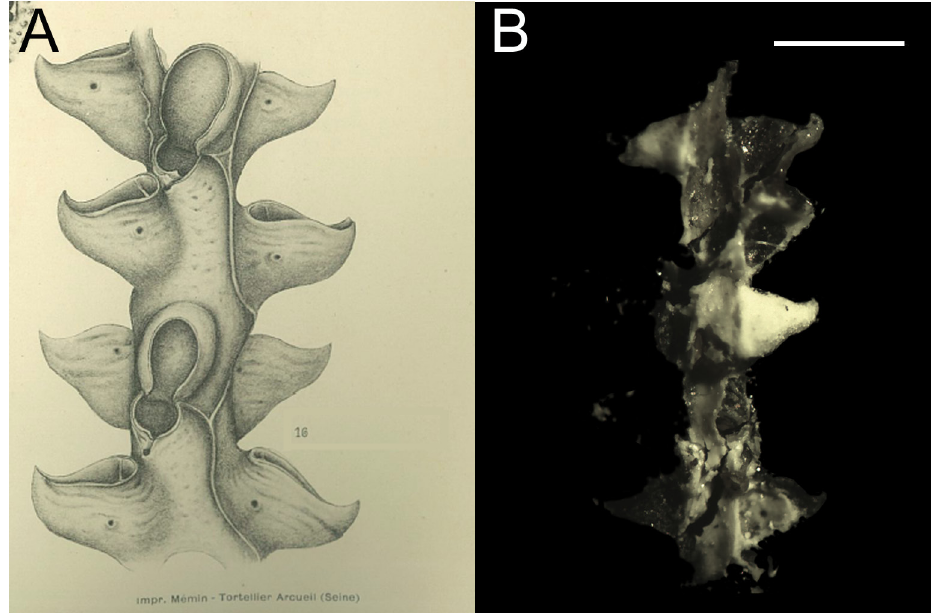
Fig. 6. Available characteristics of Schizoretepora dentata (Calvet, 1931). A . Original drawing from Calvet (1931). B . Actual condition of the type housed at MOM. Scale bar: 1